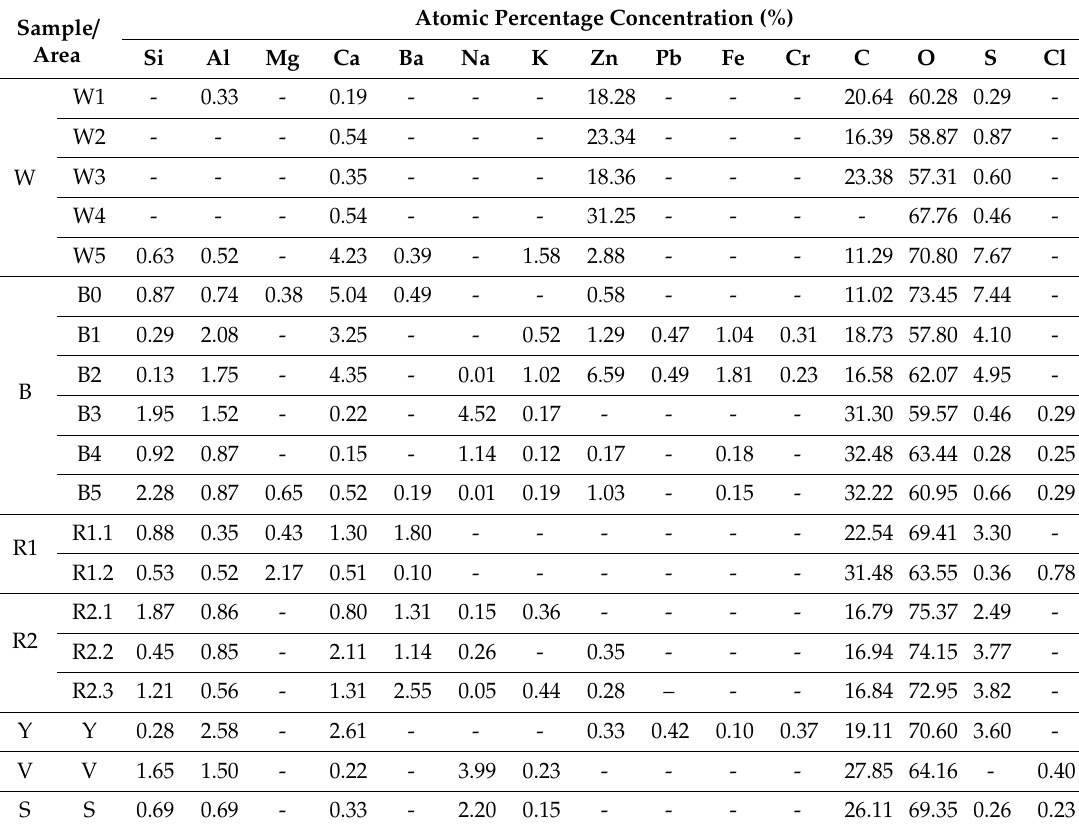
Table 1. Elemental composition of colors, varnish, and